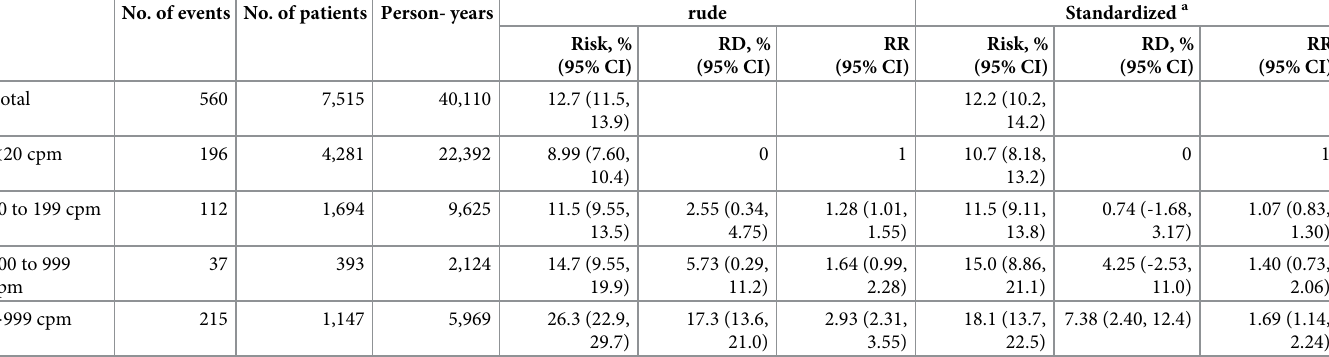
Abbreviations: CI, confidence interval; CNICS, Center for AIDS Research Network of Integrated Clinical Systems; cpm, copies per milliliter; RD, risk difference; RR, risk ratio. a Standardized estimates controlled for age, sex, race/ethnicity, male-to-male sexual contact, injection drug use, smoking, at-risk alcohol use, pre-ART viral load, year of ART initiation, ART regimen, CD4 count, clinical AIDS status, chronic hepatitis status, statin use, and study